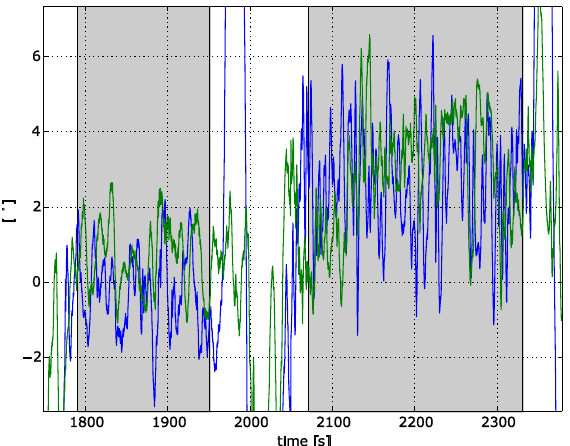
Figure 8. Roll (blue) and pitch (green) values for strip #2 (with stabilization) and strip #3 (no stabilization). Flight #1.